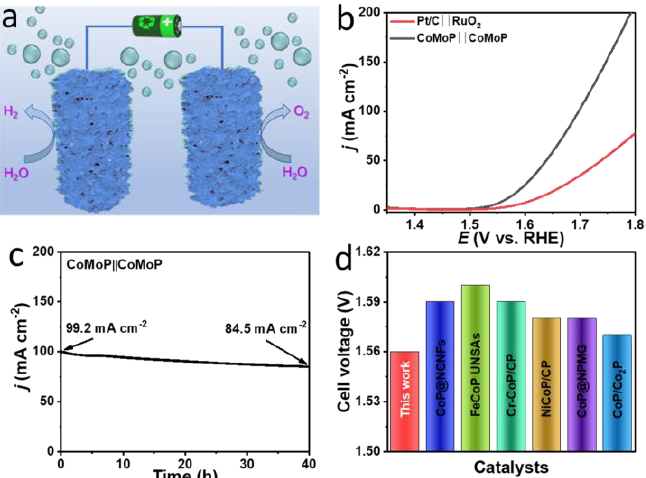
Figure 6. ( a ) Schematic diagram of the OWS in a two-electrode system. ( b ) Polarization curves of OWS cells with the electrode pairs: CoMoP||CoMoP and Pt/C||RuO 2 in 1.0 M KOH. ( c ) Chronoam- perometric curve of CoMoP in the two-electrode system at 1.70 V polarization. ( d ) Comparison of the CoMoP overpotential at 10 mA cm −2 with previously reported catalysts in 1.0 M KOH.